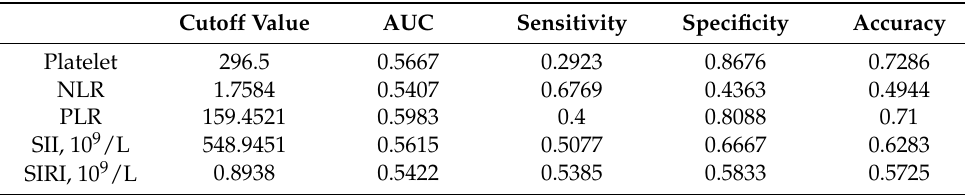
Table 1. Cutoff values of systemic inflammatory markers determined by receiver operating curves for overall survival. Cutoff Value AUC Sensitivity Specificity